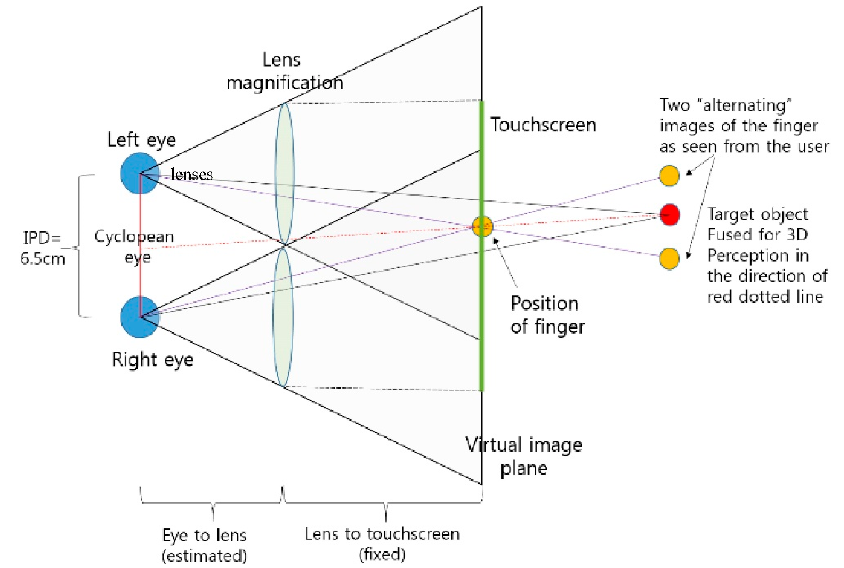
Figure 4. Working of the Blurry Touch Finger. The actual touch is made not along the perceived view direction of 3D target object from the Cyclopean eye, but in the direction from the respective eye depending on where the user touches (on the left or right screen space image).